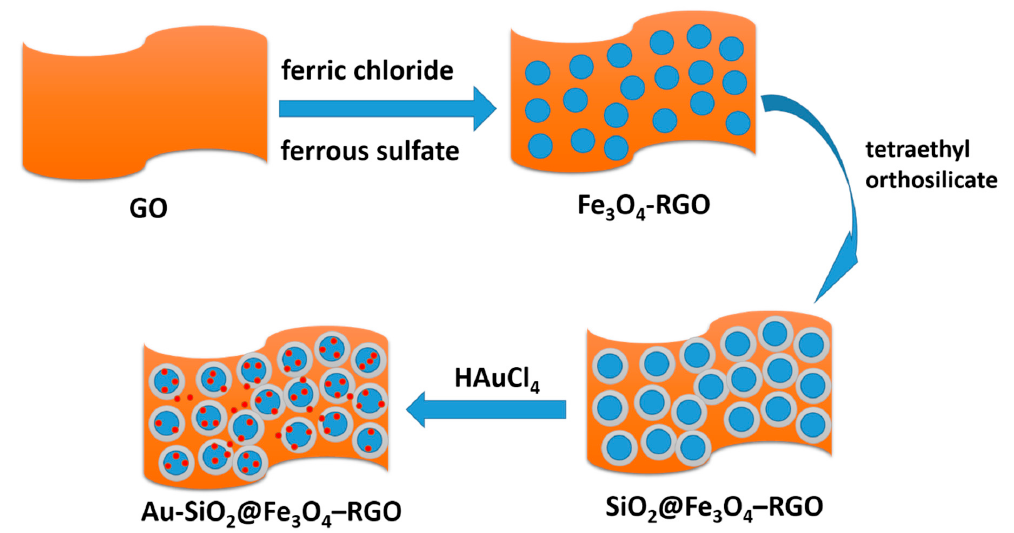
Figure 8. Illustration of the preparation of Au-SiO 2 @Fe 3 O 4 -RGO.